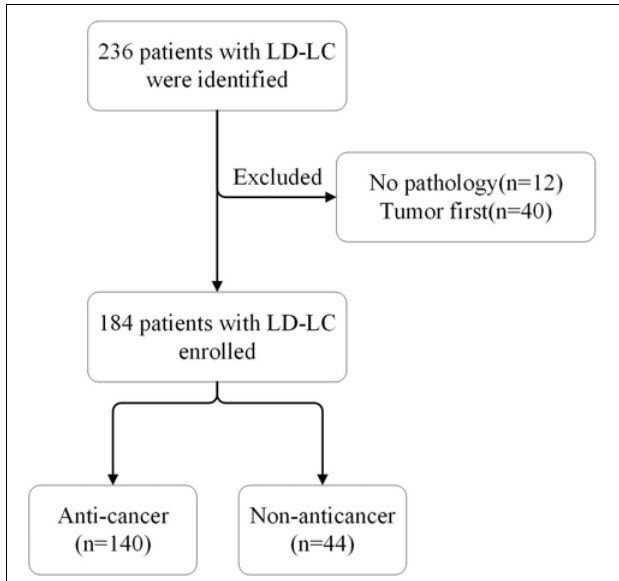
FIGURE 1 | Flowchart of the ILD-LC patients selecting